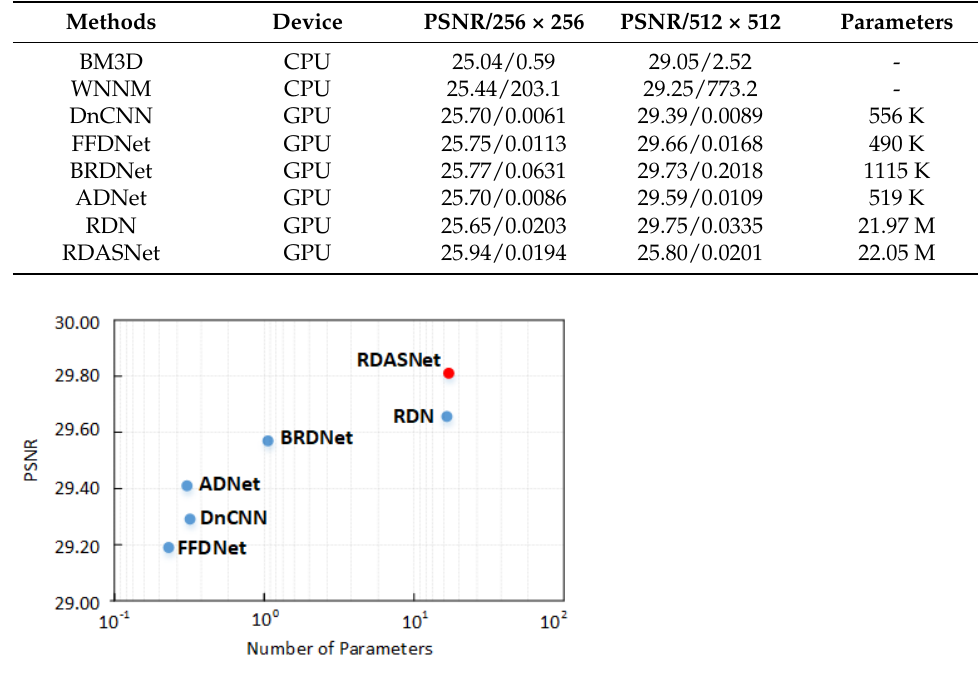
Figure 11. PSNR results on McMaster σ = 50 vs. the number of parameters of different